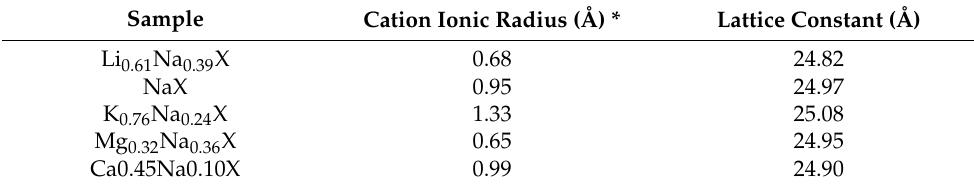
Figure 6. The (111) XRD reflexes of the sorbents after ion-exchange. Table 3. Ionic radii and lattice constants of the studied samples.